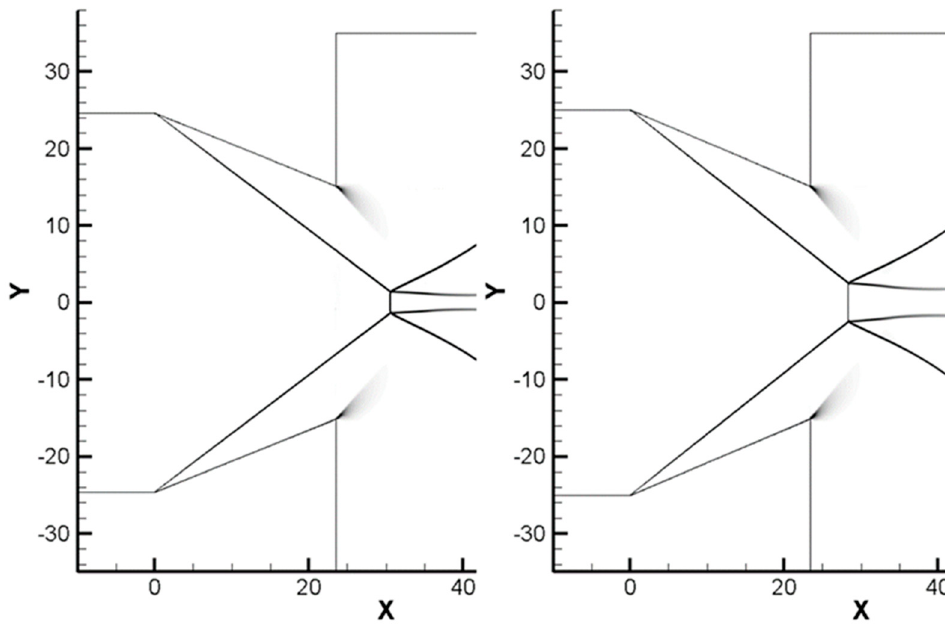
Figure 7. Transition of shock reflection for the 1.2D gap ( left , 22° wedge/ right , 23° wedge).